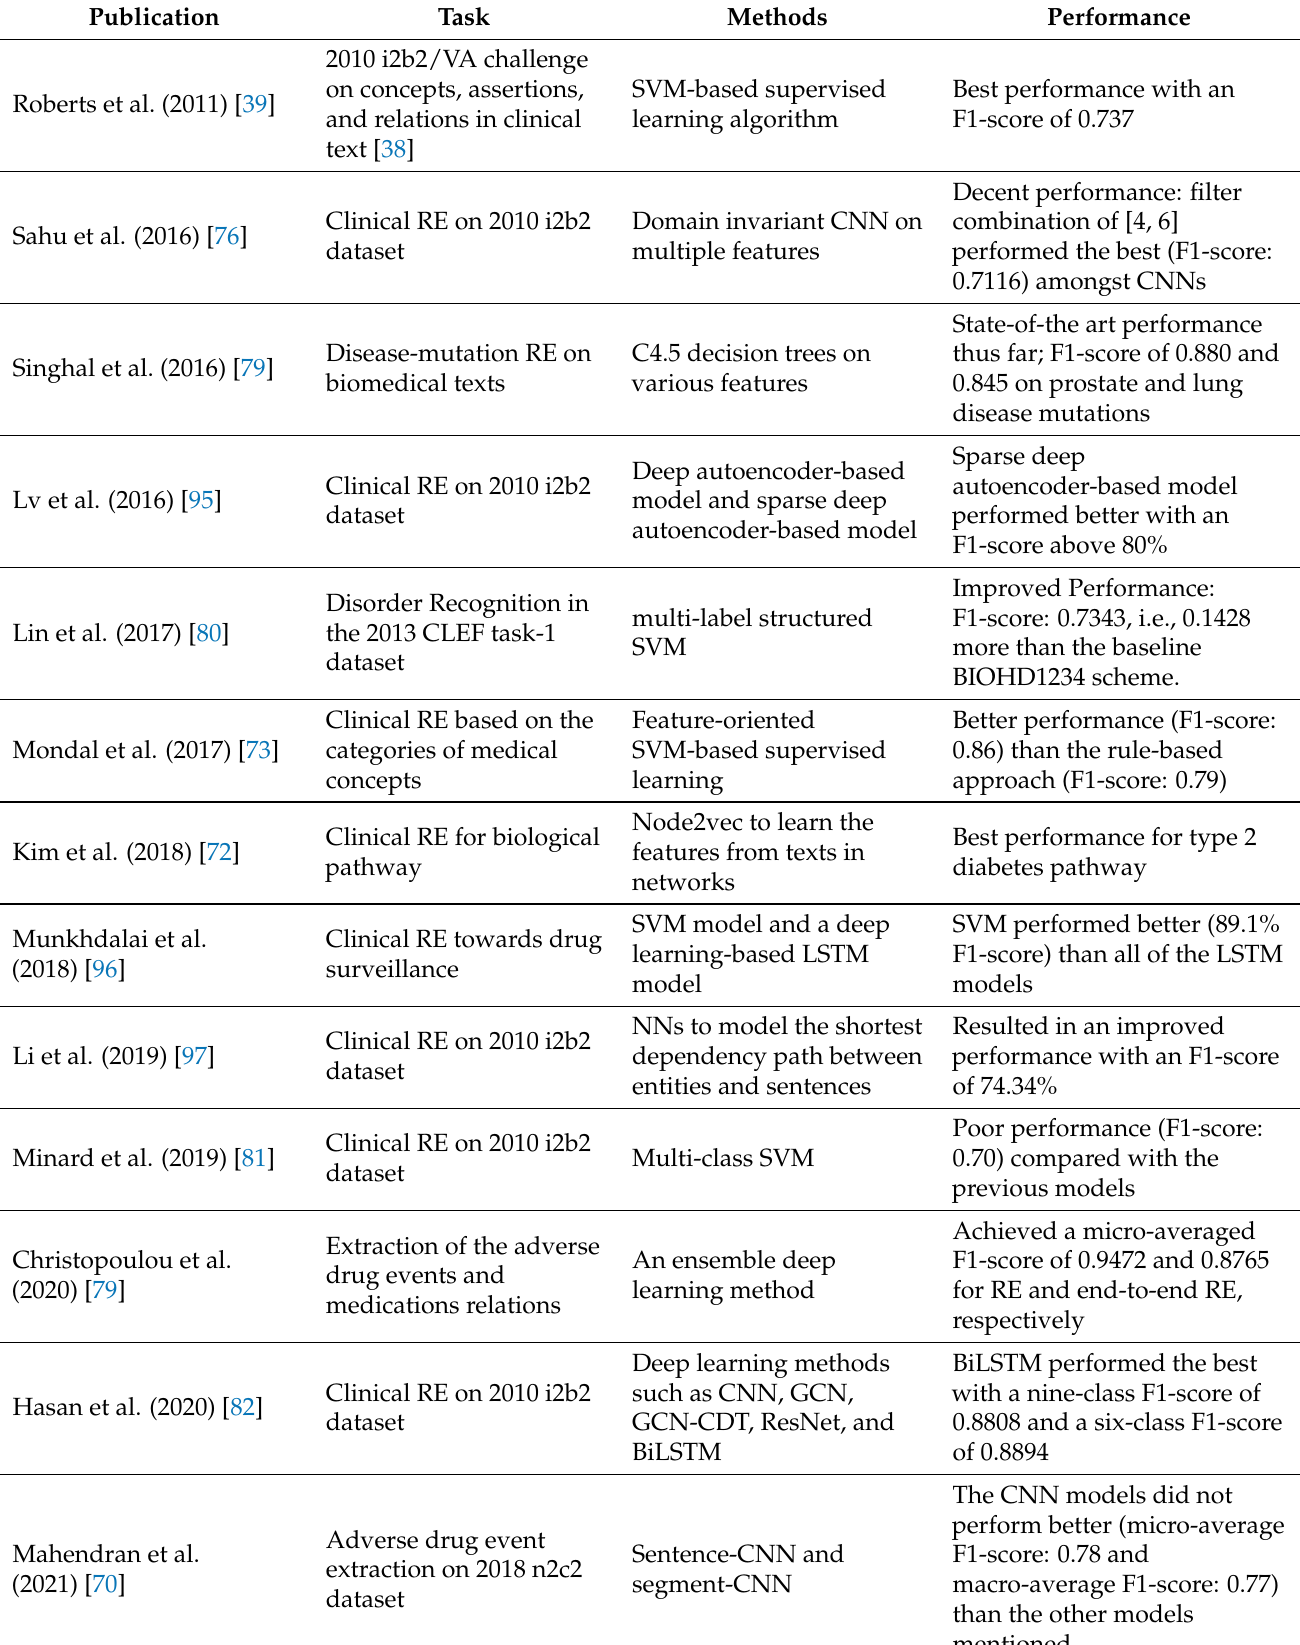
Table A4. Summary of the machine learning-based approaches for clinical